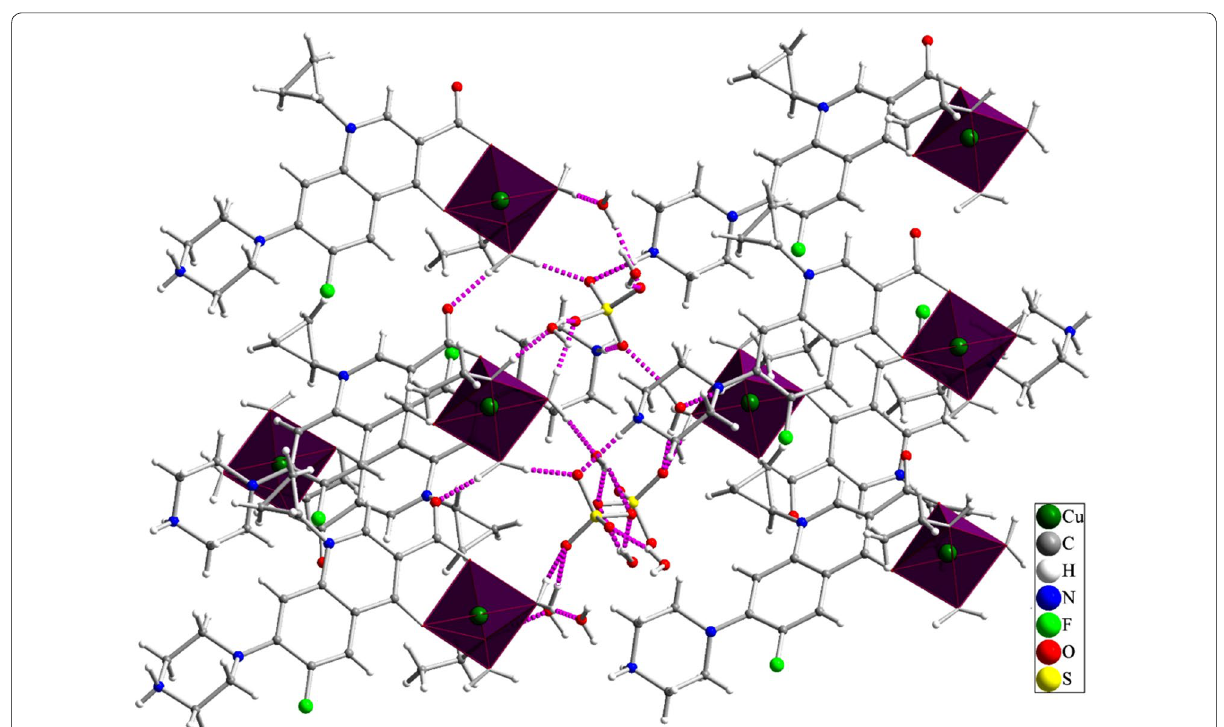
Fig. 2 Intermolecular hydrogen bond interactions (pink dashed lines) in the crystal structure of Cu-CIP